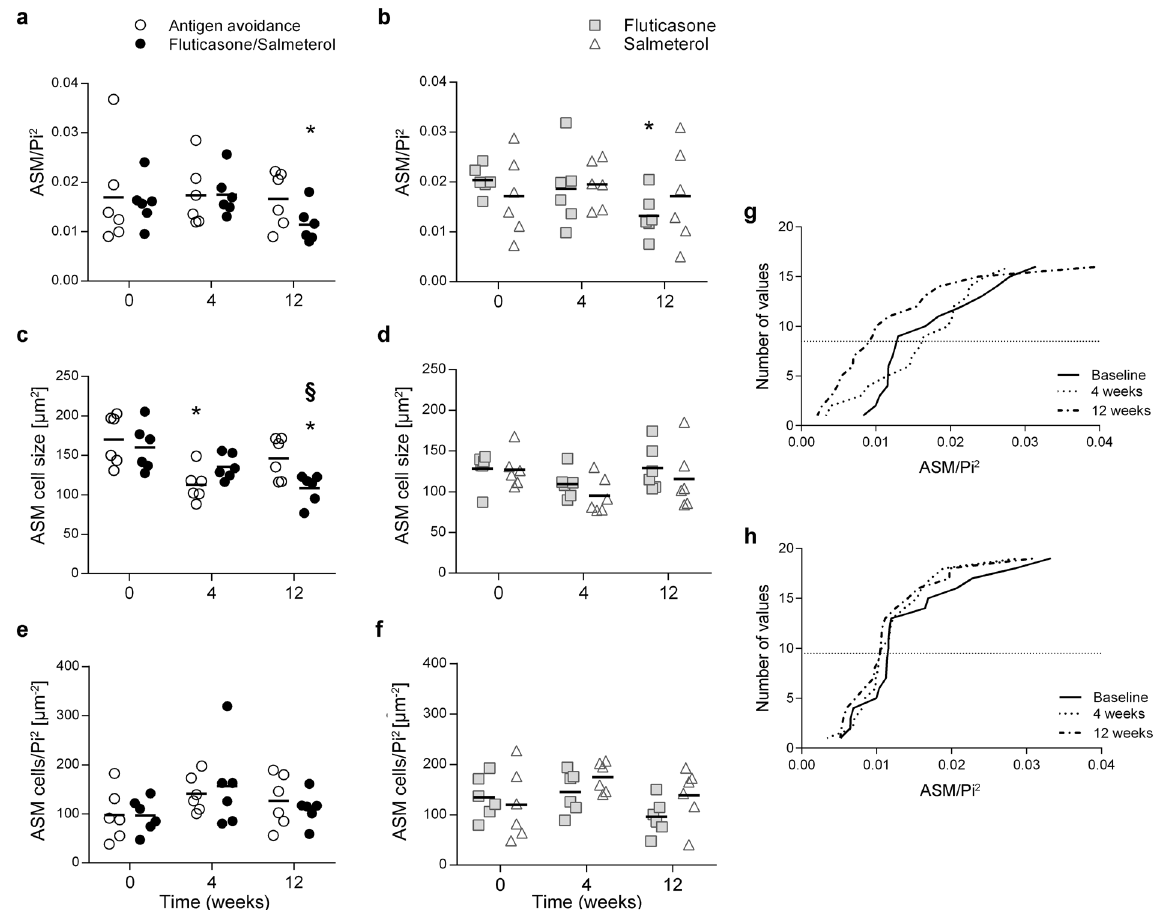
Figure 3. Peripheral airway smooth muscle remodelling. The corrected quantity of ASM, as well as ASM cell hypertrophy and hyperplasia were assessed by histology in study I ( a,c , and e , respectively) and II ( b,d , and f ). Each symbol represents one horse (mean value of multiple measures performed). * Different from baseline of the same group (p < 0.05); §difference between groups at the time point indicated (p < 0.05). ASM: airway smooth muscle; Pi: internal perimeter of the airway. ( g,h ) Representative examples of the cumulative frequency distribution of peripheral ASM remodelling (ASM/Pi 2 ) in one horse treated with fluticasone/salmeterol ( g : n = 16 airways/time) and another one treated with antigen avoidance ( h : n = 19 airways/time). Dashed lines identify median